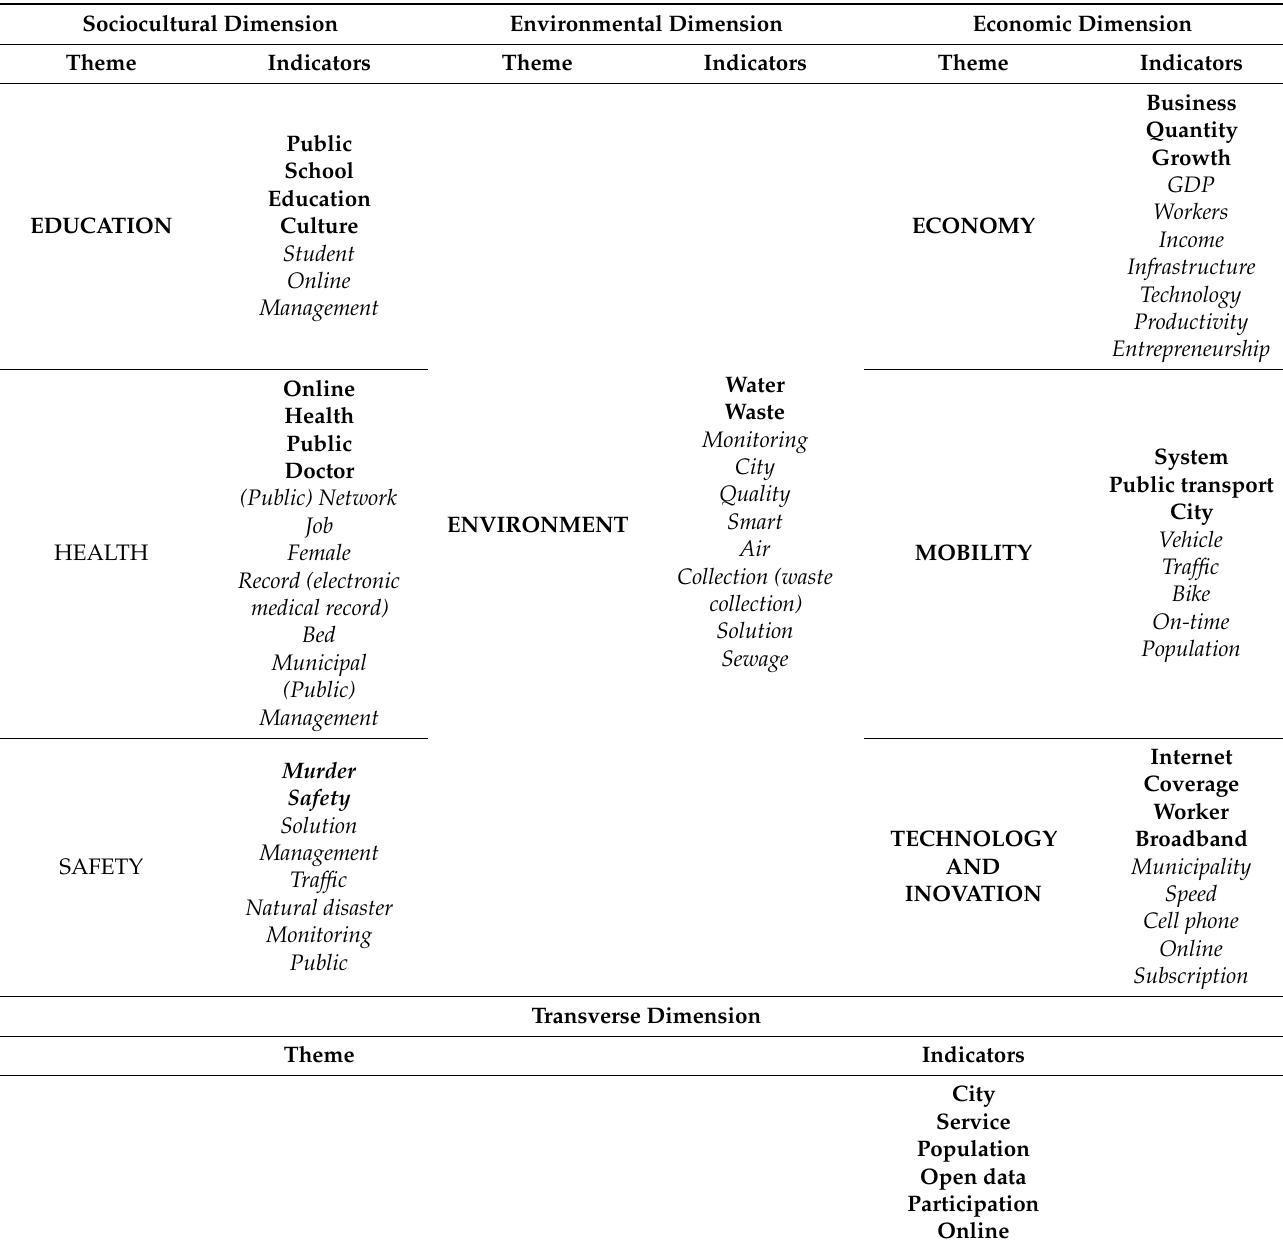
Table 5. Consolidation of the most frequent indicators within all eight